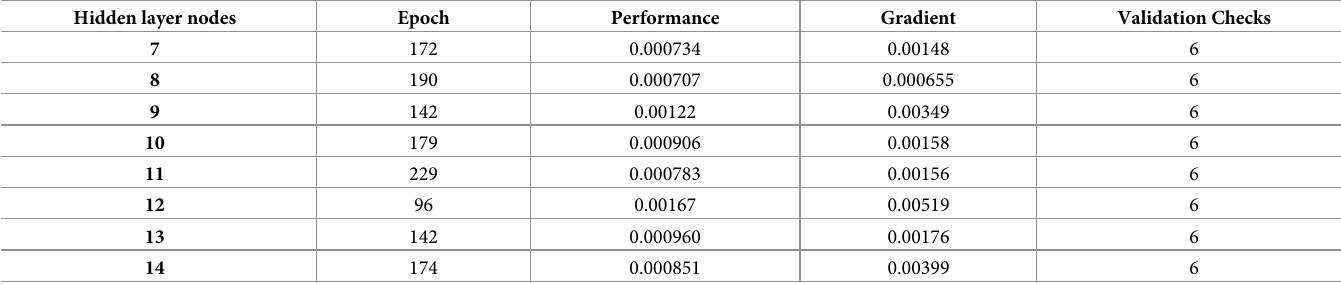
Table 3. Comparison of prediction with different hidden layer nodes (SCG). Hidden layer nodes Epoch Performance